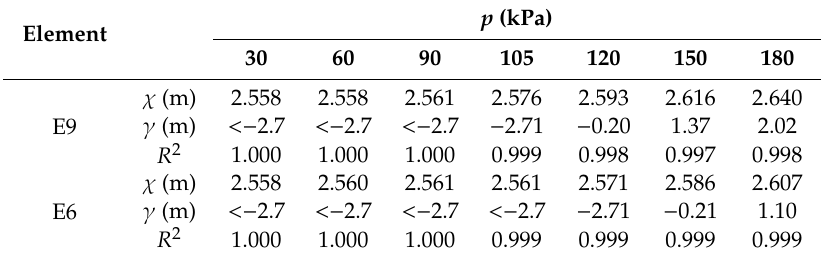
Table 3. The values of χ , γ , and R 2 from the linear best-fitting equation at each loading step.